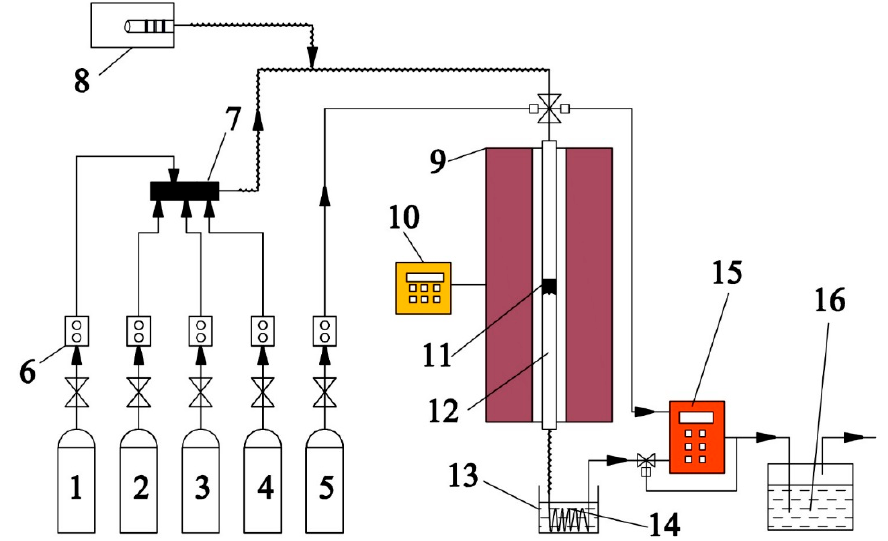
Figure 13. Catalytic performance and SO 2 oxidation tests device. 1. NO/N 2 ; 2. O 2 ; 3. N 2 ; 4. SO 2 /CO 2 ; 5. NH 3 /N 2 ; 6. Mass flowmeter; 7. Gas mixer; 8. Peristaltic pump; 9. Tubular resistance furnace; 10.